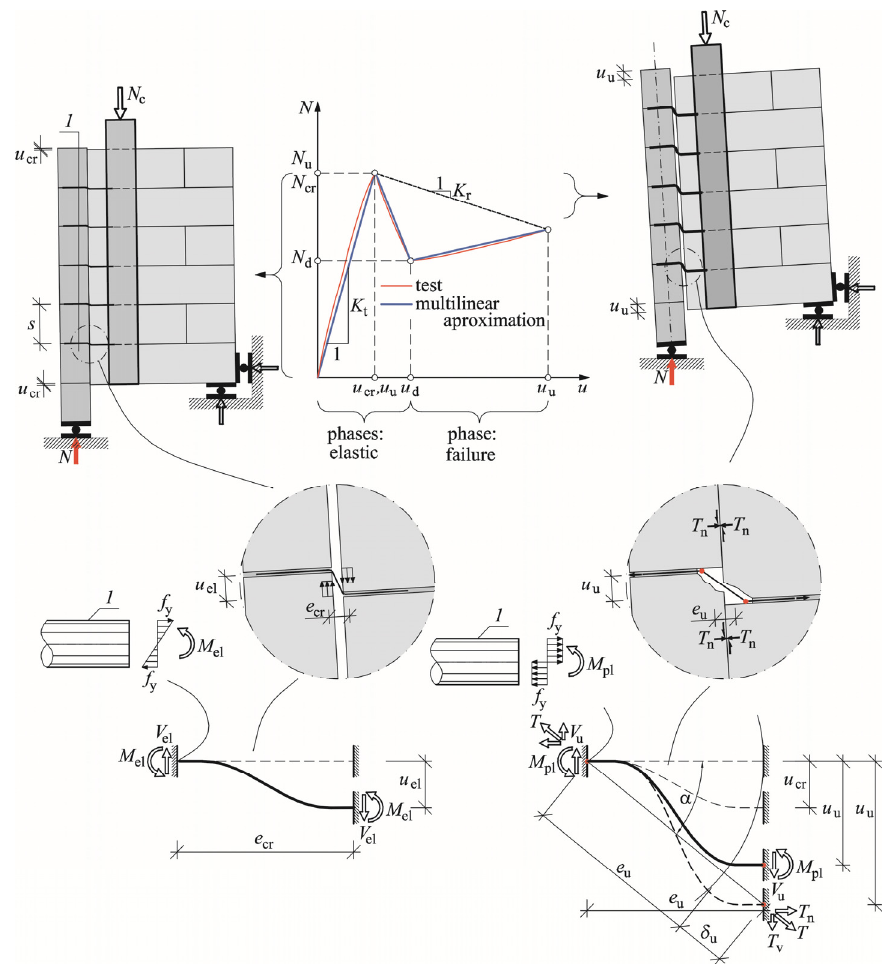
Figure 10. Approximation of work of reinforced joint between masonry walls (connector ( 1 )). Values of forces and corresponding displacements are presented in Tables 9 and 10. Joint stiffnesses were determined in each phase according to Equations (1) – (3) and they are presented in Table 11. A linear approximation of results is shown in Figure 10. Table 9. Test results for reinforced joints ( forces).